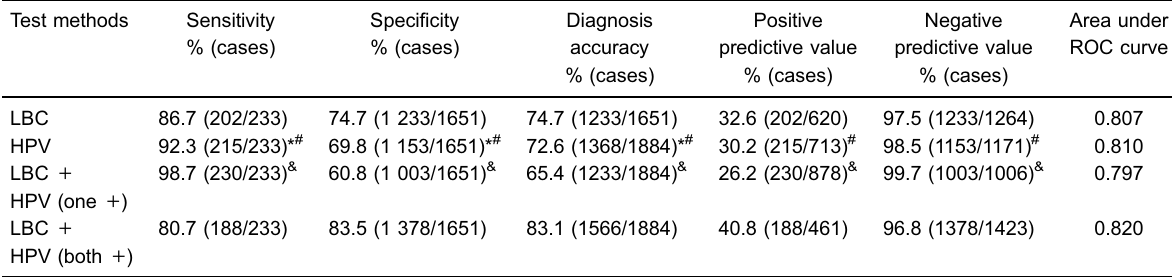
Table 2. Clinical assessments of different combination